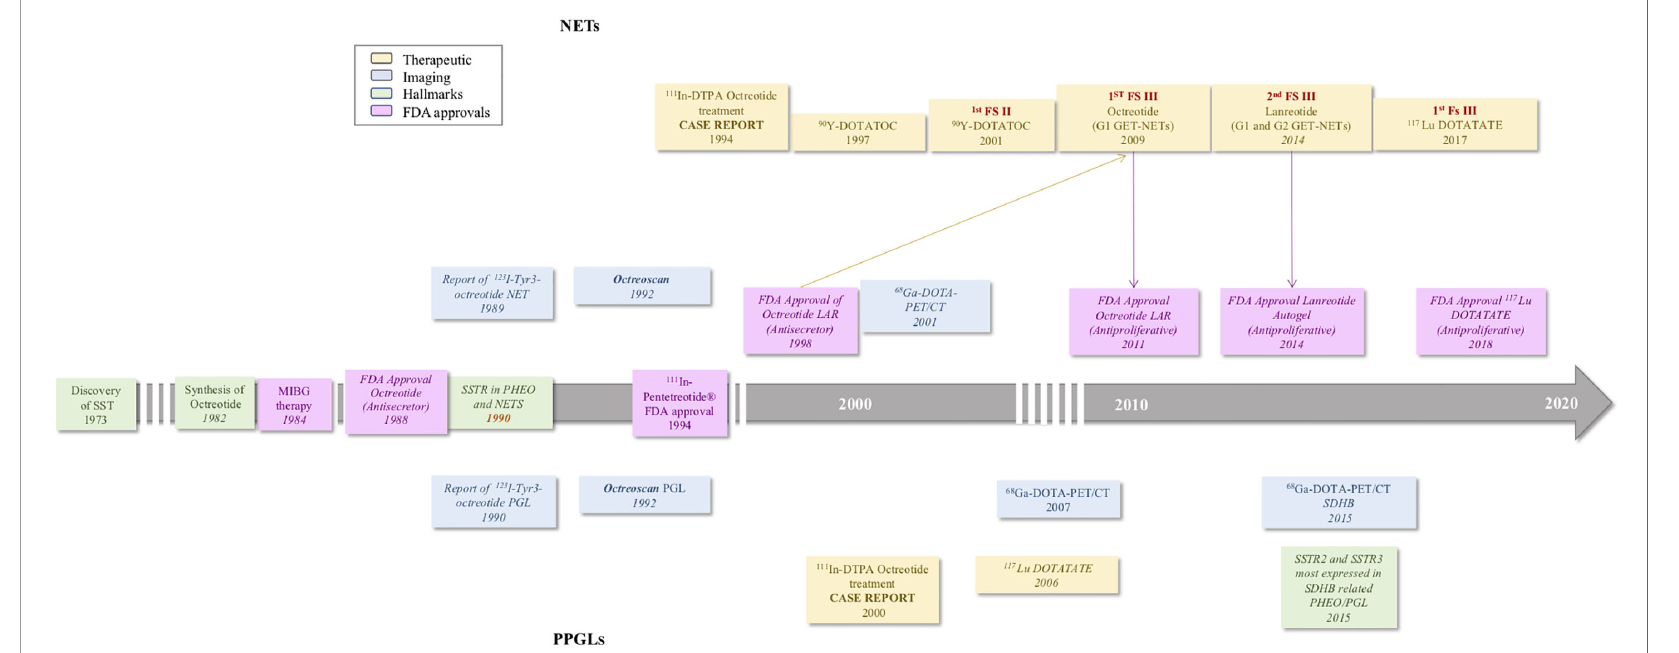
FIGURE 1 | Timeline of important events in the development of somatostatin receptors and targeting analogs in neuroendocrine tumors and Pheochromocytoma and Paragangliomas (1 – 7, 30, 40 –